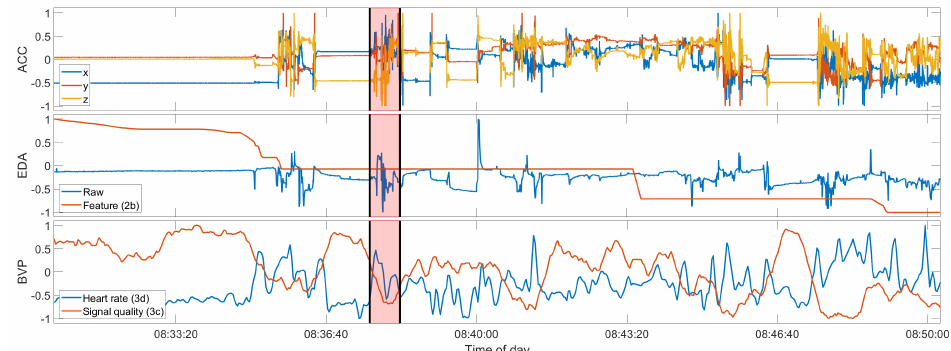
Figure 5. Seizure UKF2-2, a false negative. Compare also to Figure 3. Data shown from top to bottom: raw ACC, raw EDA and feature 2b, heart rate and BVP signal quality index. The red overlay is the seizure ground truth. The seizure onset and offset are additionally marked by the black vertical bars. All signals shown are normalized between − 1 to 1 only for these plots. The original value ranges before normalization can be found in Table